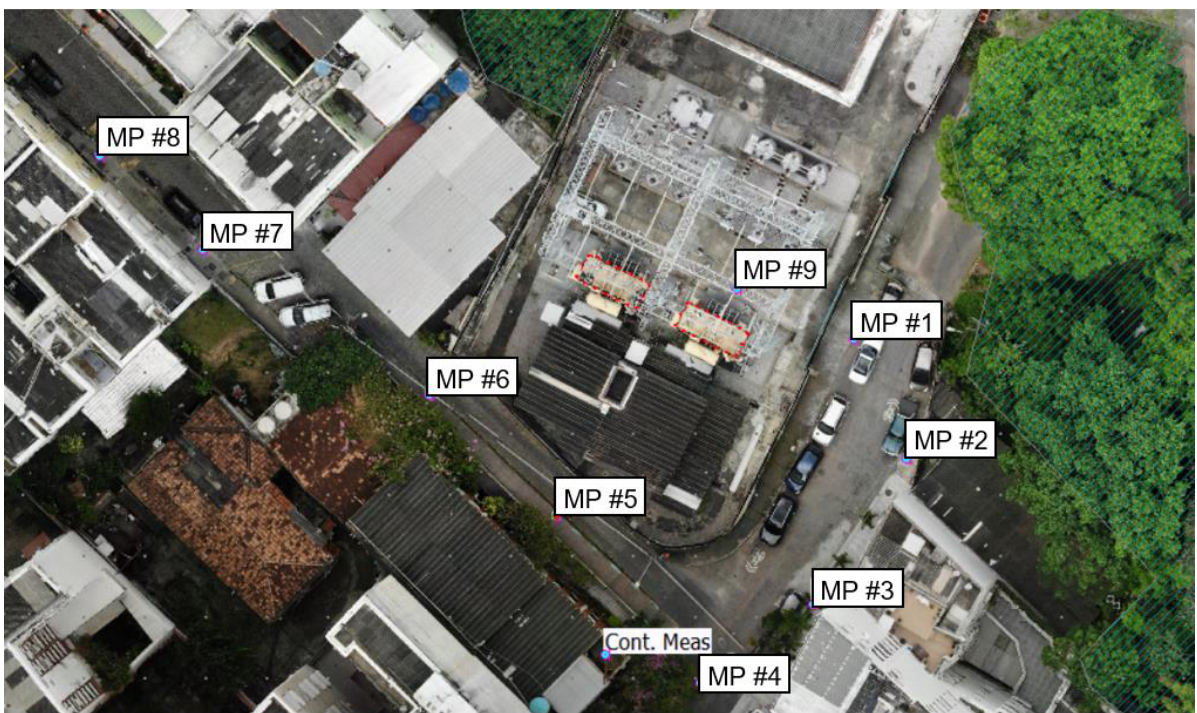
Figure 3. Sound pressure measurement locations in the vicinity of the